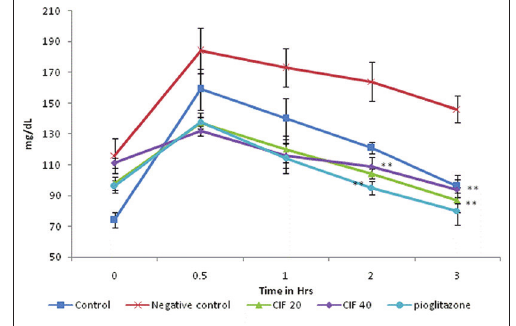
FIGURE 2. Effect on oral glucose tolerance test after 7 th week of STZ administration in rats pretreated with CIF (n=10). Blood glucose levels of CIF 20, 40 and pioglitazone treatments were compared with that of negative control group at respective time intervals. * p<0.05, **